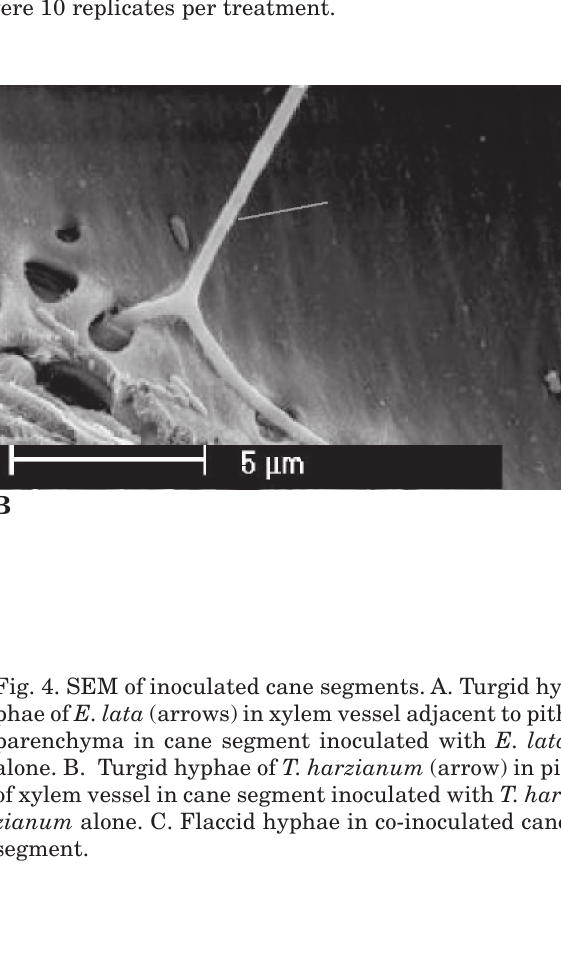
Fig. 3. Colonisation of autoclaved segments of Shiraz canes by E. lata 4 weeks after simulataneous co-inoculation with 1,000 spores of E. lata and T. harzianum AG1. There were 10 replicates per treatment.